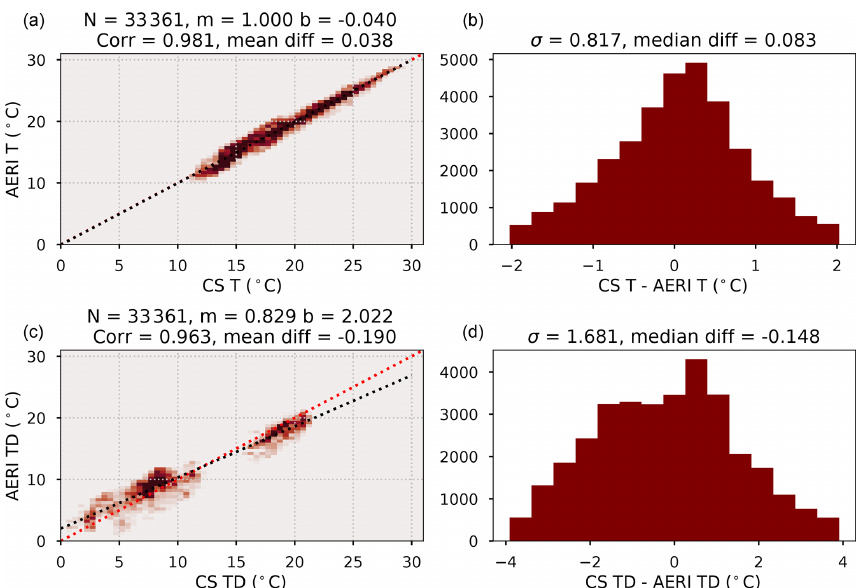
Figure 5. Similar to Fig. 4 but for the temperature (a, b) and dew point temperature (c, d) . The 2D histograms of temperature and dew point temperature are binned by 0.5 ◦